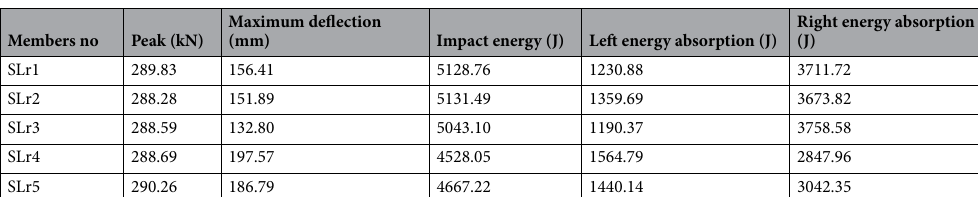
Table 9. Statistics of members with various aspect